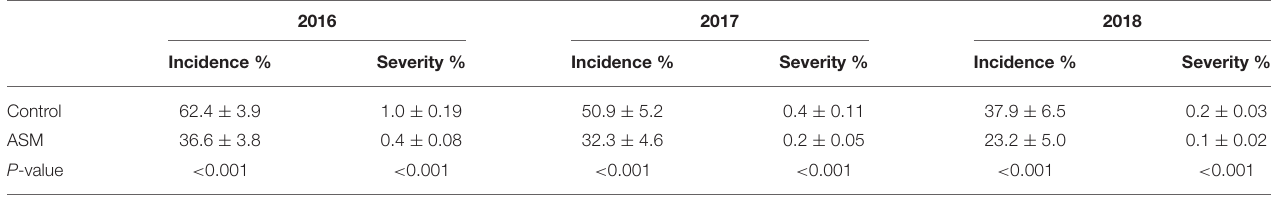
TABLE 5 | Incidence and severity of leaf spotting caused by Pseudomonas syringae pv. actinidiae in mature Actinidia chinensis var. deliciosa ‘Hayward’ vines at Ruakura Research